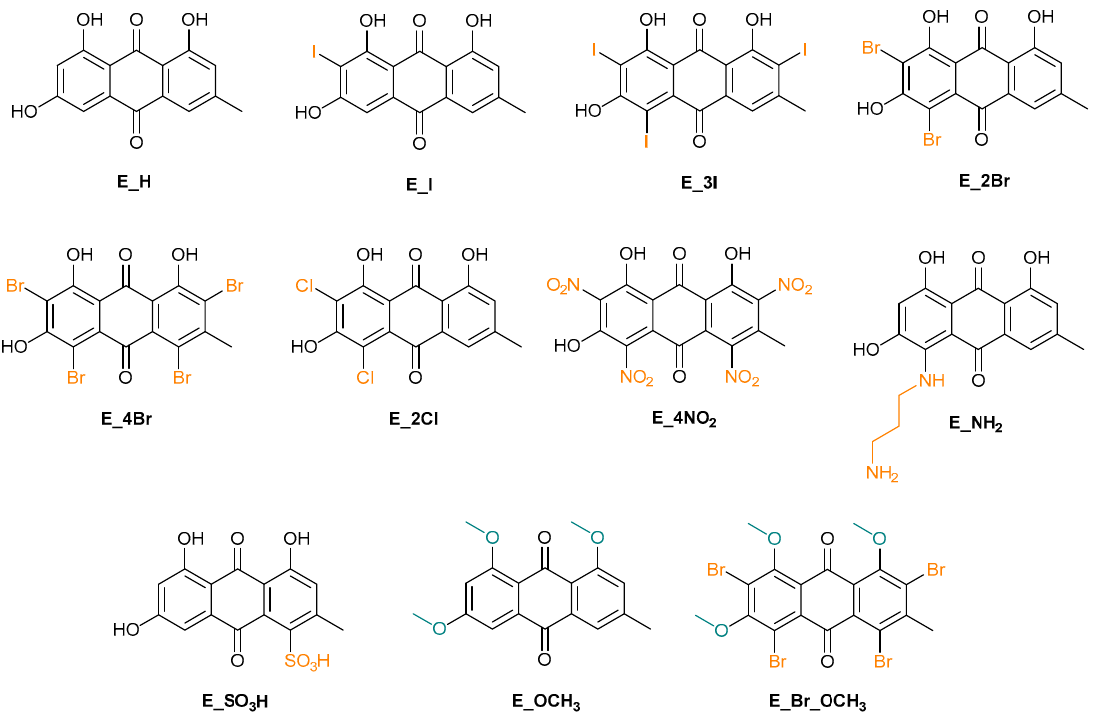
Figure 4. Emodin and emodin derivatives prepared in the course of this study.